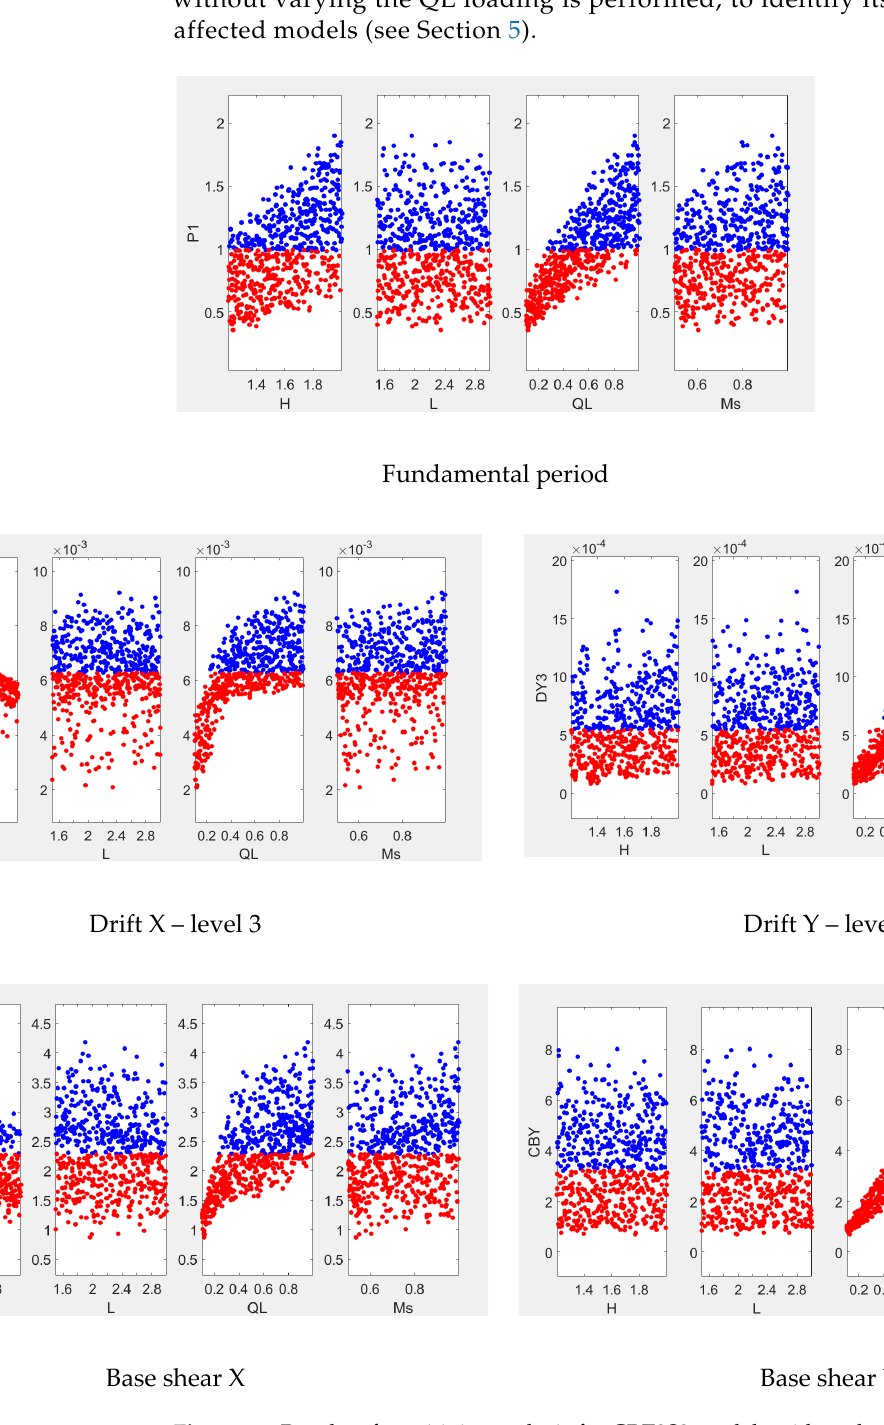
Figure 11. Results of sensitivity analysis for CBZ3S3 models without bracing towers racks models.